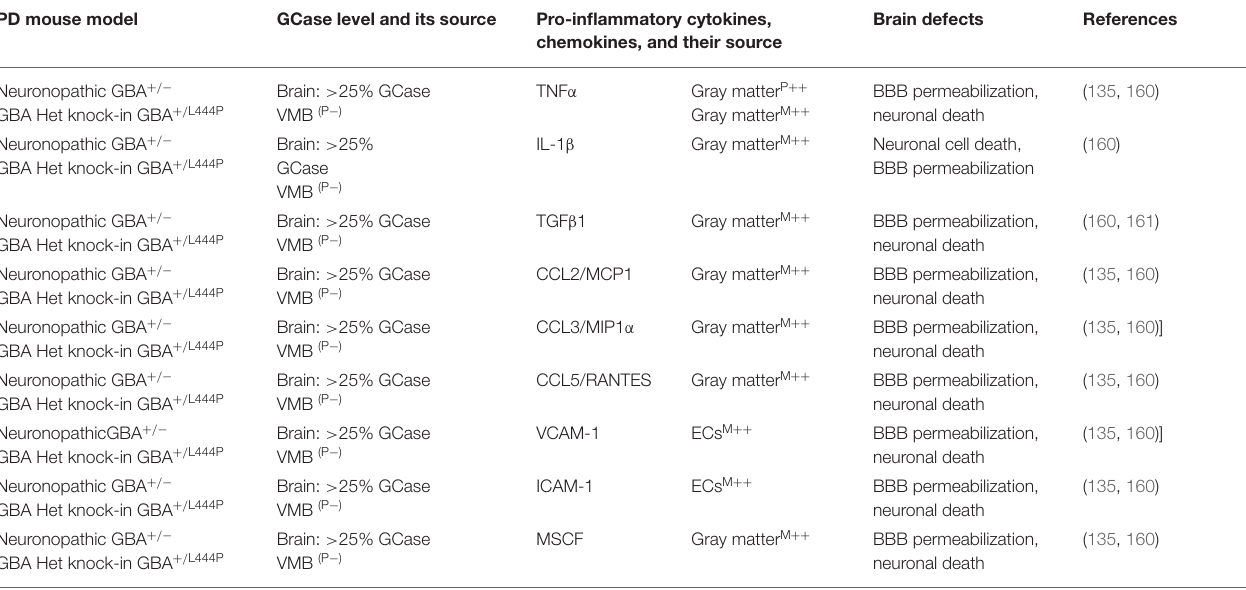
TABLE 3A | Cytokines and their source in the mouse model of GBA1